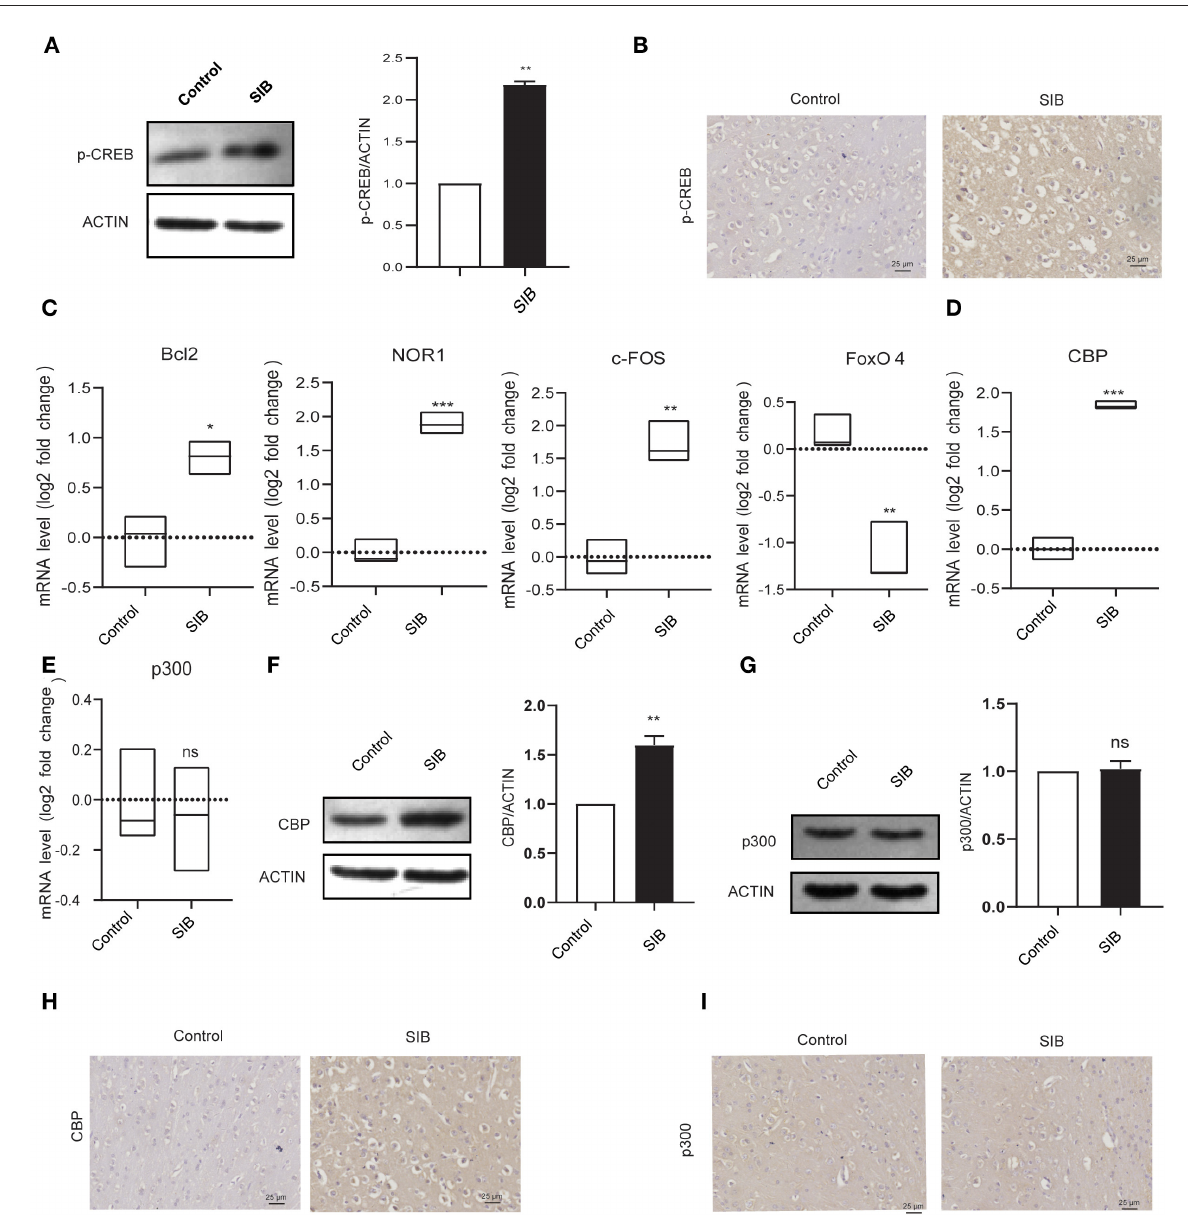
sustained administration of Inhibitor improved duration of the sleep of minks with SIB (Figure 4C, ∗∗ p < 0.01) and increased dietary amount (Figure 4D, ∗ p < 0.05), drinking frequency (Figure 4E, ∗ p < 0.05) and defecation frequency